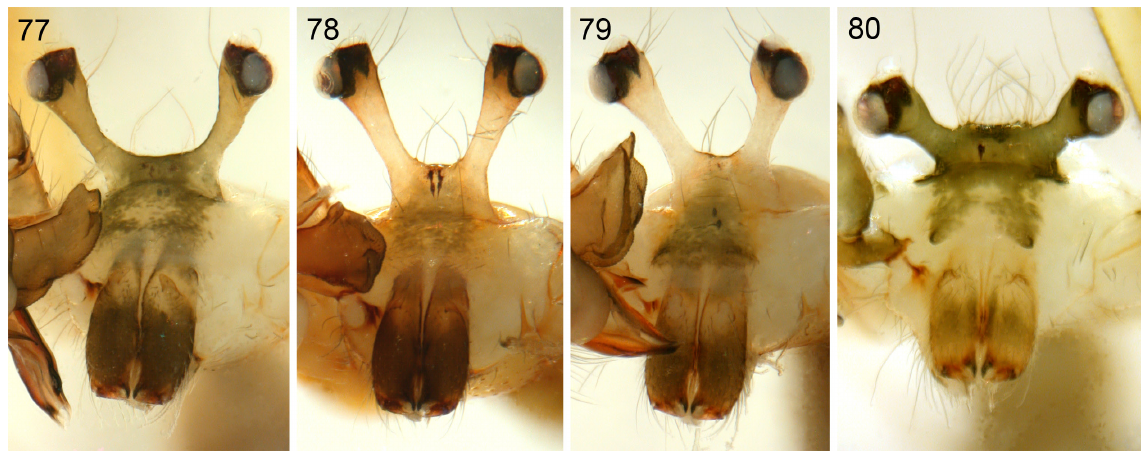
Figs 77–80. Male prosomata, frontal views. 77 . Pholcus tanahrata Huber sp. nov. 78 . P. uludong Huber